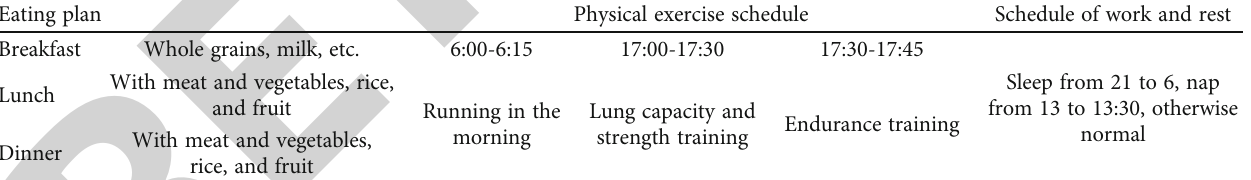
Table 2: Health management